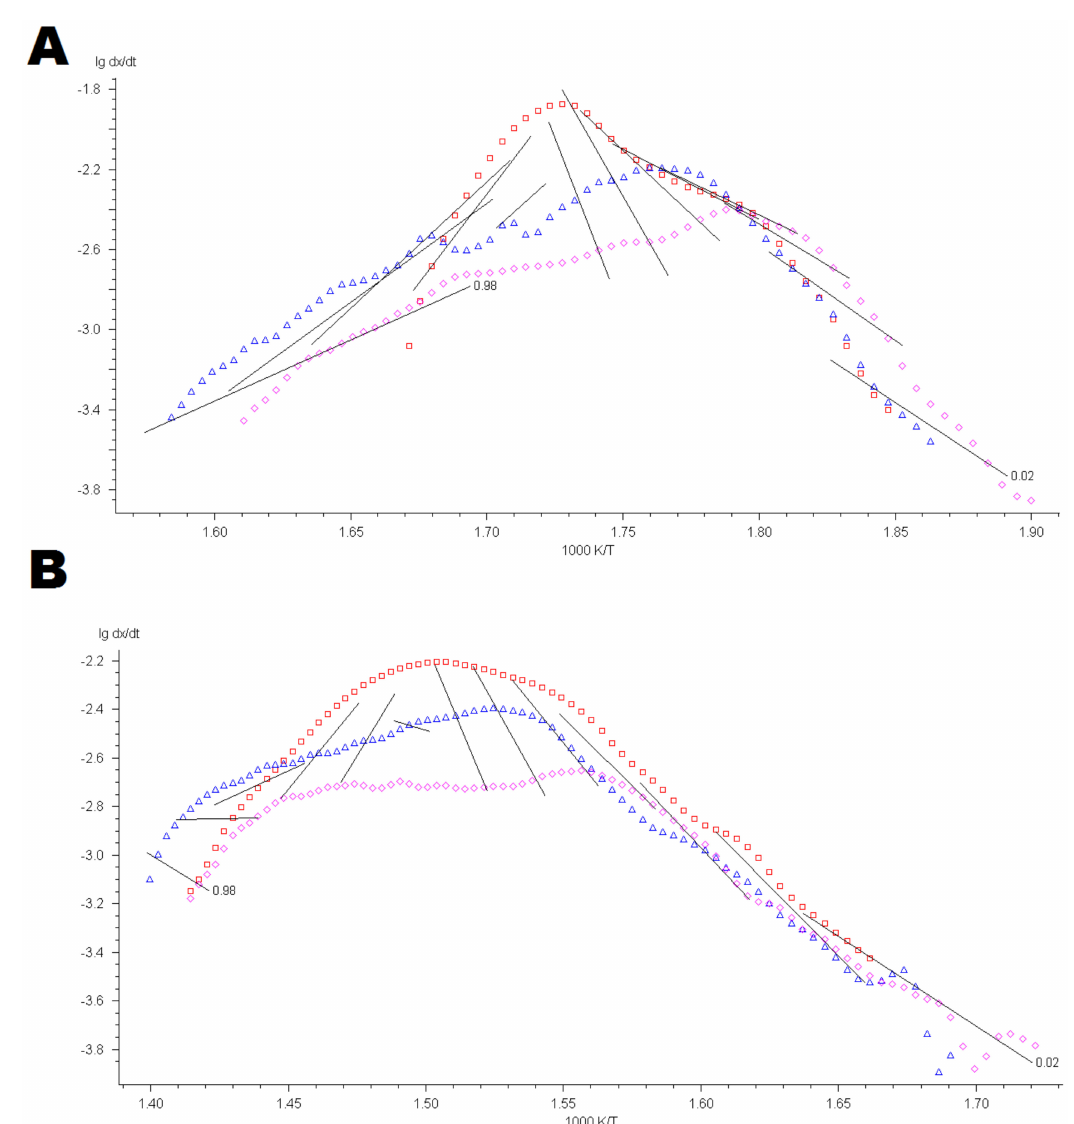
Figure A1. Friedman POM-P analysis plot lg (reaction rate) vs. 1000 K/T: ( A ) sample investigated in an oxygen atmosphere; ( B ) sample investigated in an inert atmosphere. Lines are drawn through isoconversion points for the measurement with 10 ( ♦ ), 15 ( ∆ ), and 20 ( (cid:3) ) ◦ C/min heating